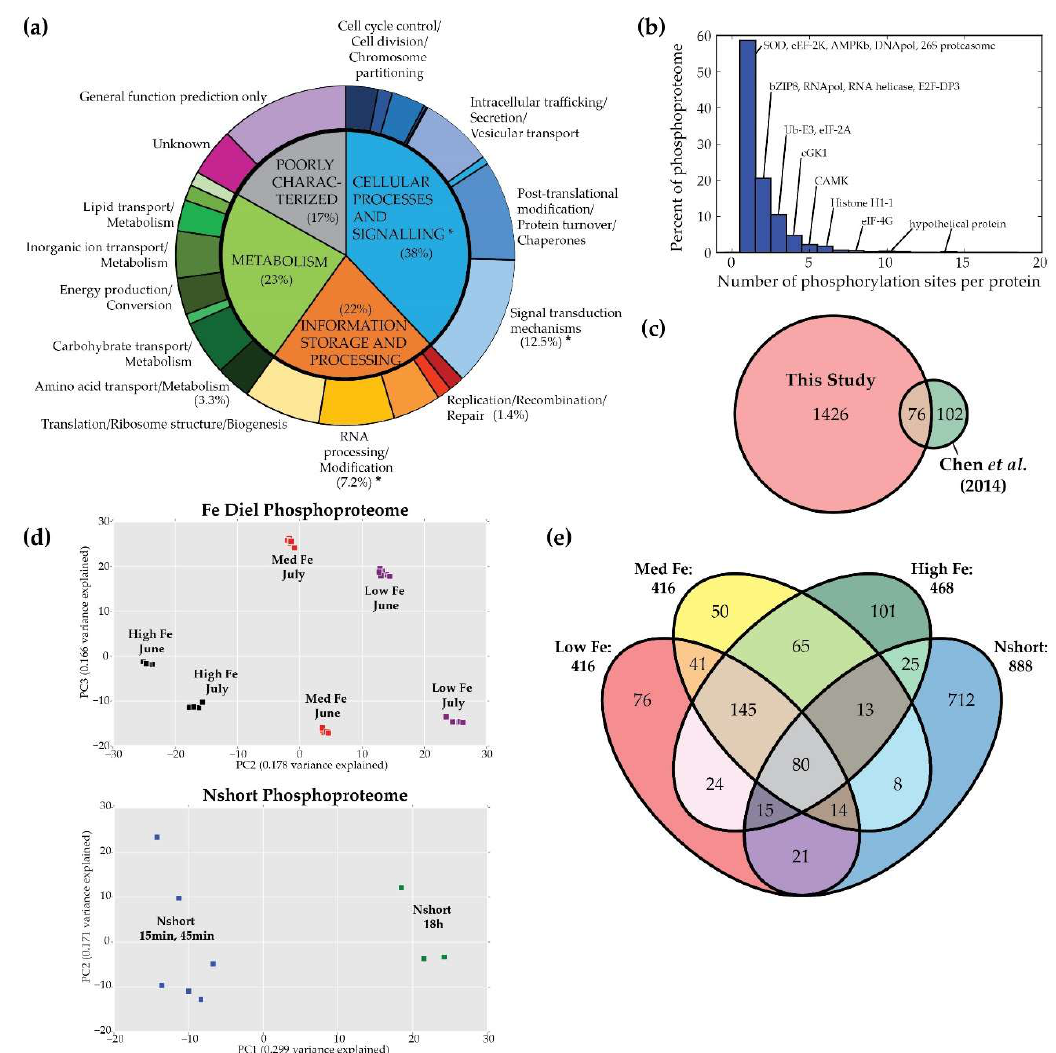
Figure 1. Summary of the phosphoproteome of P. tricornutum . ( a ) Proportions of